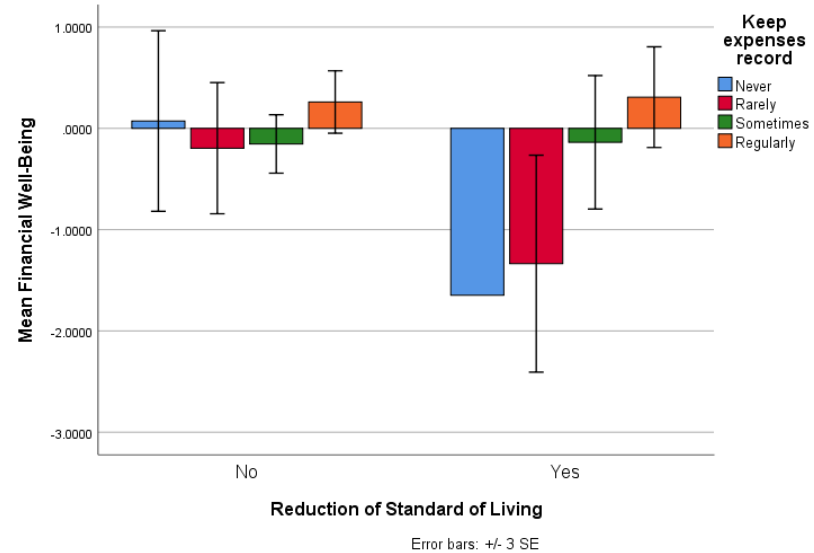
Figure 6. Distribution of financial well-being scores for students who felt a reduction of standard of living and kept expenses record versus those who did not Table 15. Independent samples t -tests for the factors by reduction in standard of living